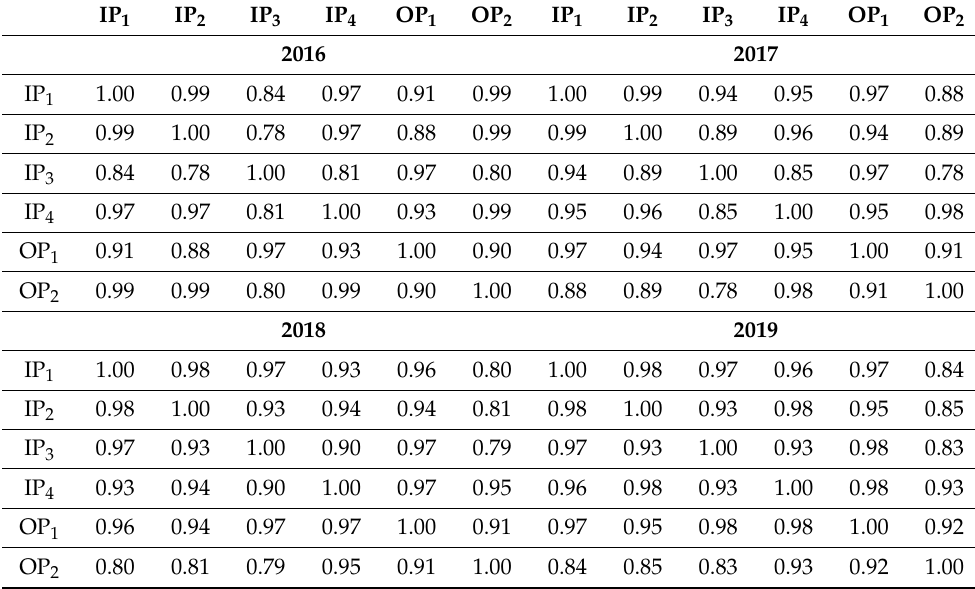
Table 14. Correlation of inputs and